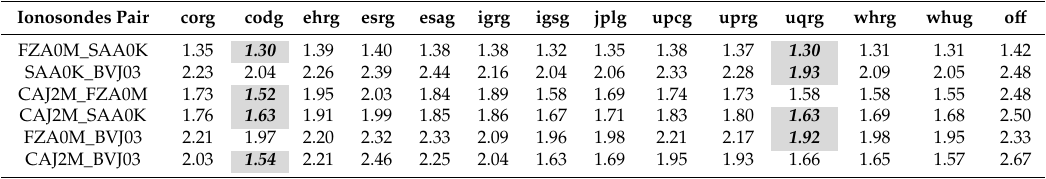
Table 4. One-year (2015) mean RMS values of the differences between fo F 2 values measured and estimated with GIMs and the simple difference between the values of both ionosondes (off). Ionosondes Pair corg codg ehrg esrg esag igrg igsg jplg upcg uprg uqrg whrg whug o ff